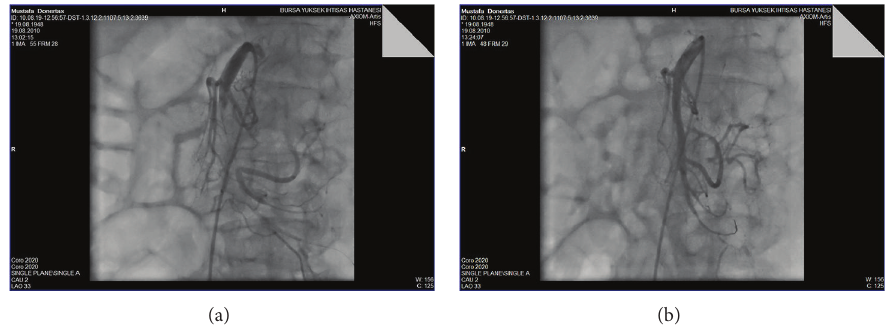
Figure 3: Angiographic appearance of the superior mesenteric artery. (a) Angiographic image of a thrombotic SMA. (b) Angiographic image of the patient after implantation of the stents. SMA: superior mesenteric